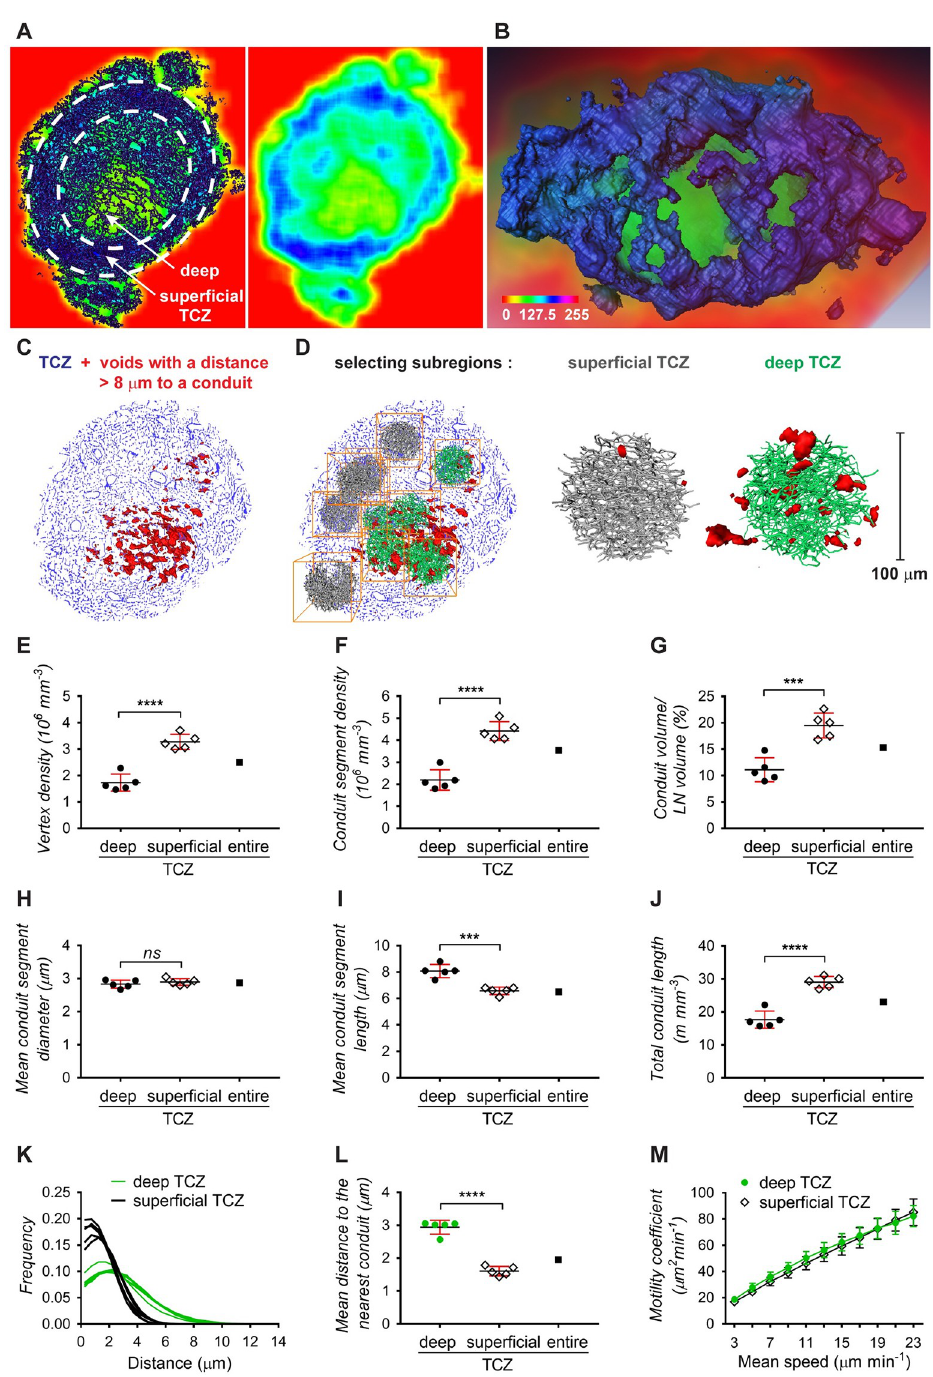
Fig 3. Comparison of conduit network parameters in the deep and superficial TCZ. Differences in conduit density between the deep and superficial TCZ can be visualized by averaging and color-coding pixel densities over small image volumes in a “moving average” display, shown as a rainbow spectrum (A, B). A cross-section of the moving average display exposes how dense regions in the periphery of the LN (blue) surround an inner region of lower conduit density (green), directly representing dense or sparse occurrence of conduit segments in the corresponding section of the conduit network image (dark blue, left panel), respectively (A). Volume rendering (B) of the entire TCZ using this approach shows the dense superficial zone (blue) enclosing a central region of sparse conduits (green). Alternatively, the TCZ conduit map was employed for calculating the distances to the nearest conduit, and voids with a distance